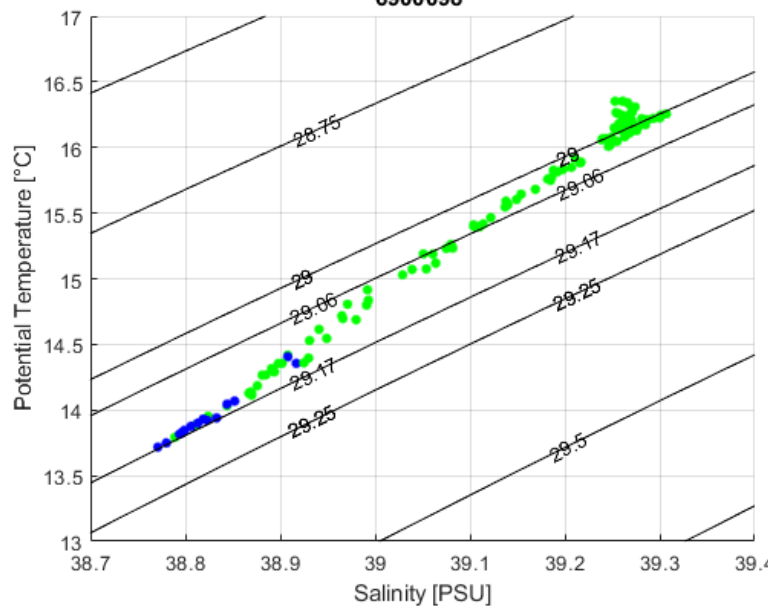
Figure 20. T / S plot for float WMO 6900098 for March 2007. Green points indicate depths from 100 to 500 m while blue points indicate depths from 500 to 600 m. The additional density line with a potential density value of 29.17 kgm −3 shows the upper deep-water boundary density while the potential density lines of 29 – 29.06 × kgm −3 represent the potential density range of typical LIW [6].